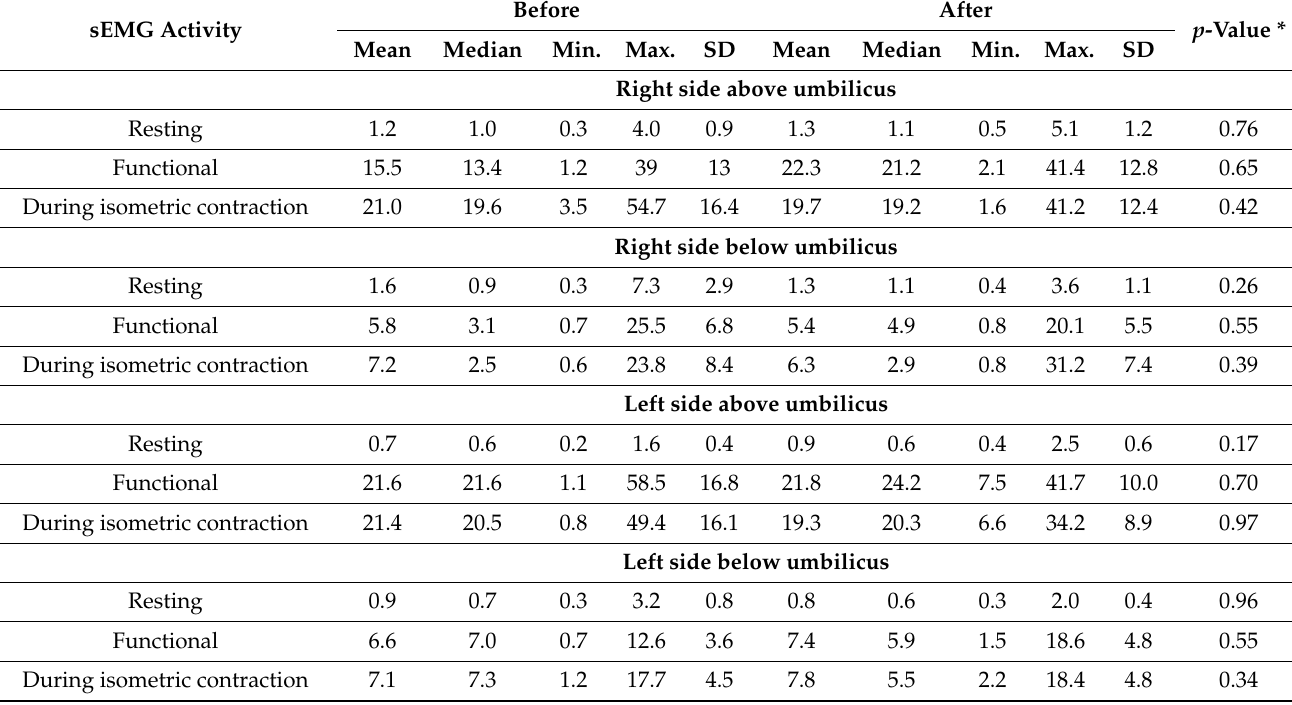
Table 3. sEMG measurements before and after the KT application in the intervention group. sEMG Activity